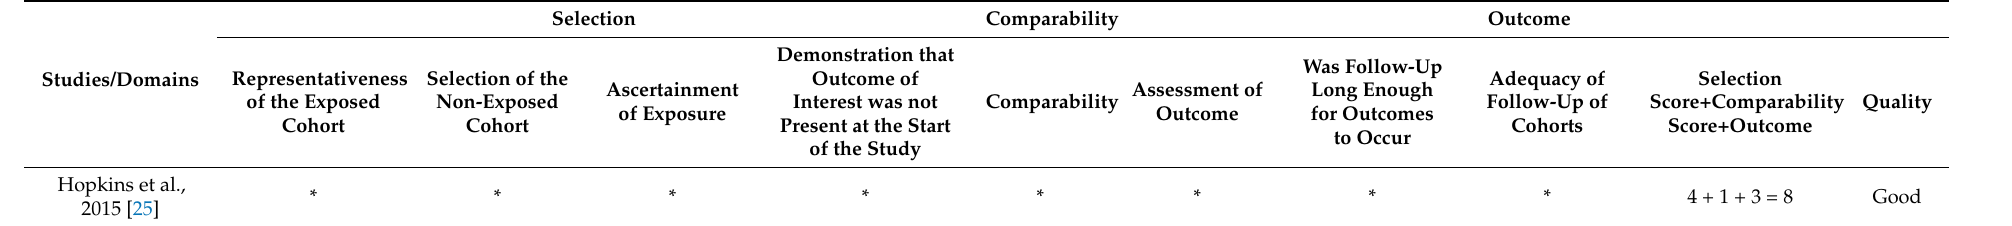
Table 5. Quality assessment of cohort studies.